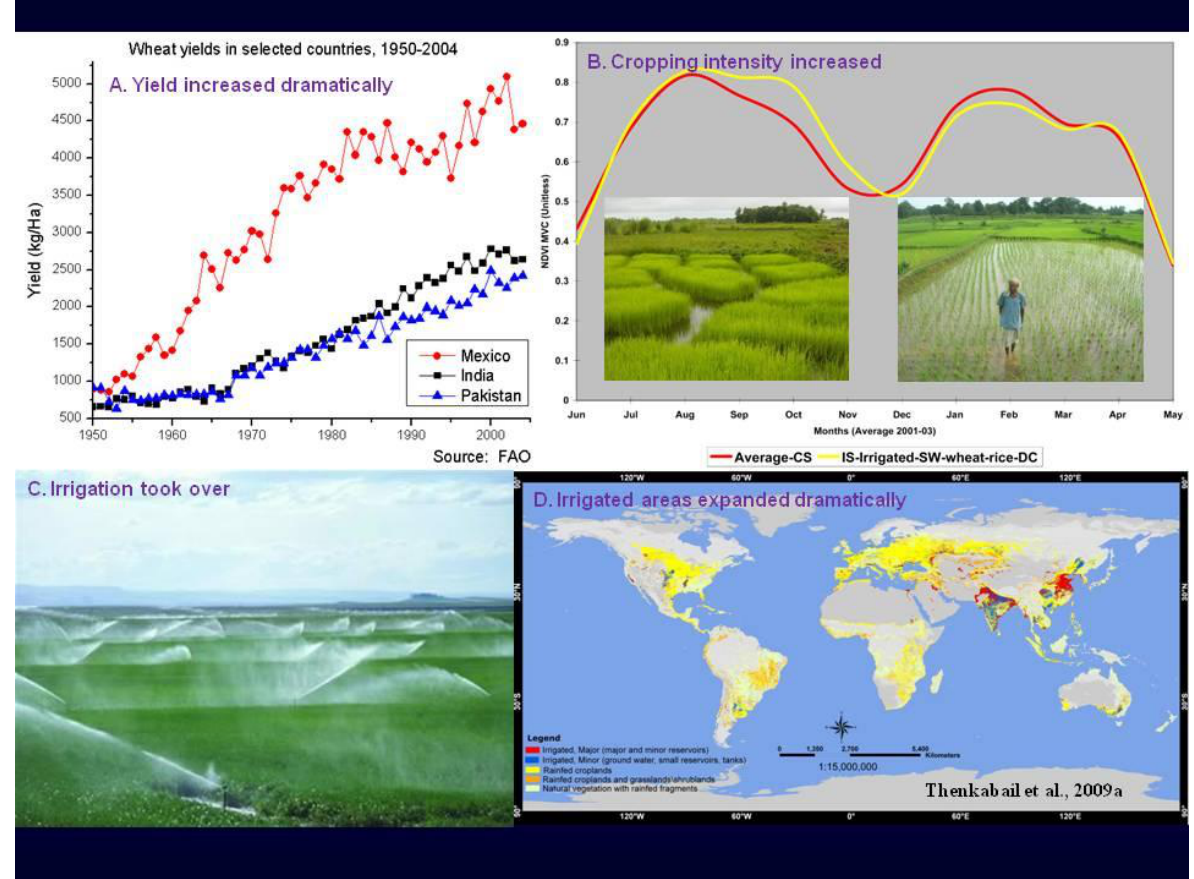
Figure 1. Green revolution (productivity per unit of land). Some of the major factors that helped achieve green revolution (years: 1955–2005) are illustrated. These factors included: (A) swift rise in yield per unit of land (e.g., through better land management, introduction of high-fast yield varieties, fertilizer, nutrients, and herbicides), (B) crop intensification (e.g., double and triple crop per year), (C) massive investments in irrigation, and (D) increase in cropland